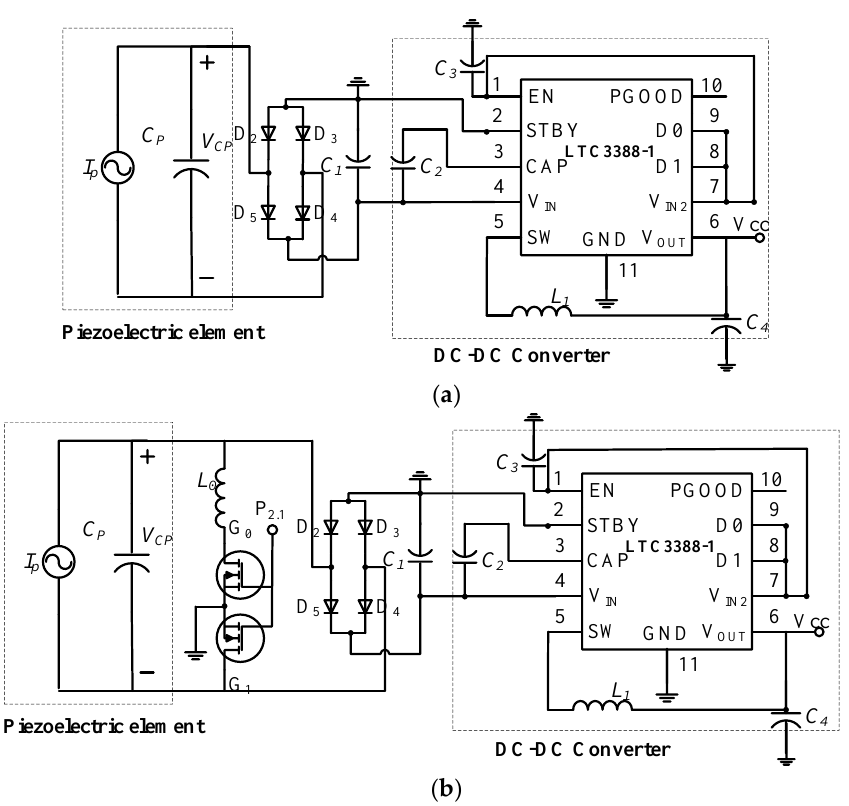
Figure 6. Impedance-matched interface circuits. ( a ) Impedance-matched bridge rectifier circuit; ( b ) Impedance-matched P-SSHI circuit.